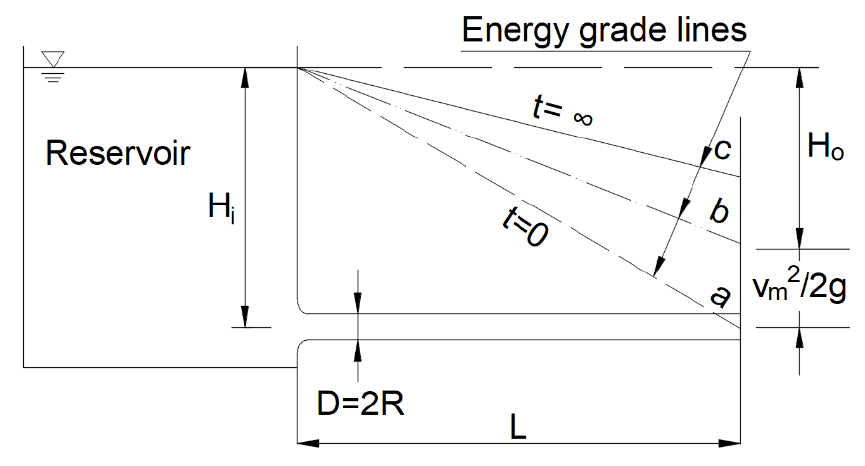
Figure 8. Otis reference drawing indicating time variation of energy grade line (adapted from [35]). During a flow acceleration, some portion of this head is utilized to establish the kinetic head of the flow. The above is illustrated in Figure 8 in which there are three energy grade lines: (a) just after the instantaneous valve opening, (b) at a later time and (c) after reaching steady-state flow (Hagen–Poiseuille steady state). During flow development, the pressure gradient along the pipe is diminished because of the observed velocity head